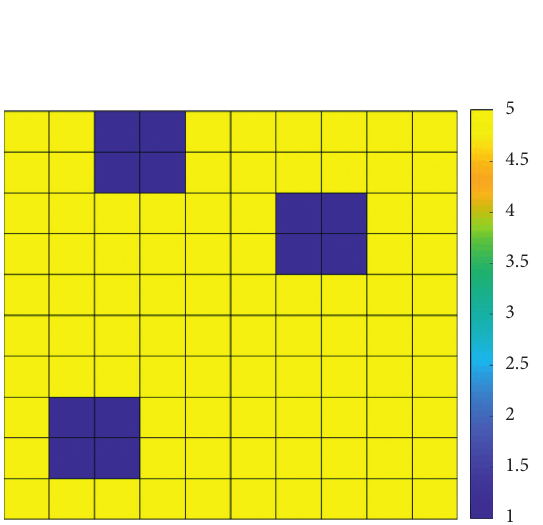
Figure 11: Relative permittivity distribution of materials with